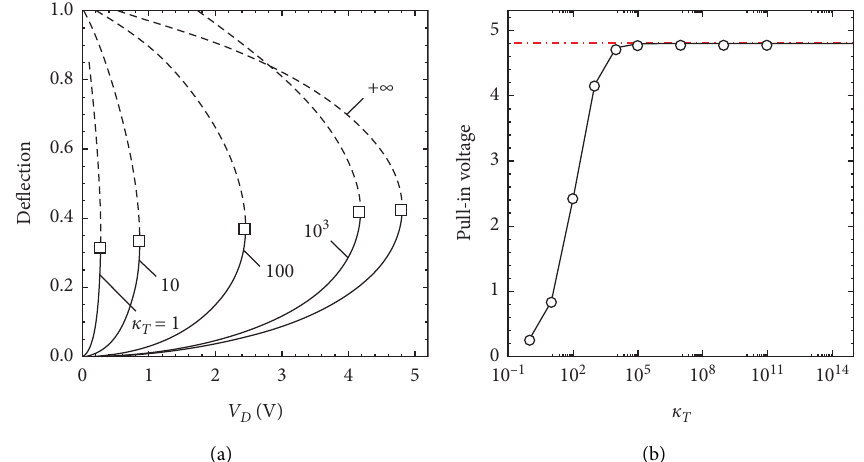
Figure 4: The effect of translational stiffness on static features by applying the first five-order symmetry modes. (a) Relationship between maximum displacement and DC voltage under different translational stiffness. (b) Variation trend of the pull-in voltage with translational